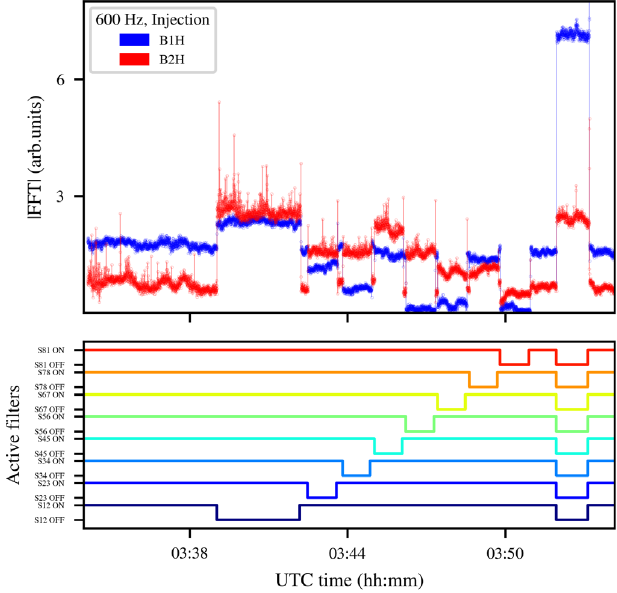
FIG. 14. The response of the h ¼ 12 harmonic (top) during the tests with the active filters for Beam 1 (blue) and Beam 2 (red) at injection energy. The status of the active filters is color-coded with the sector number